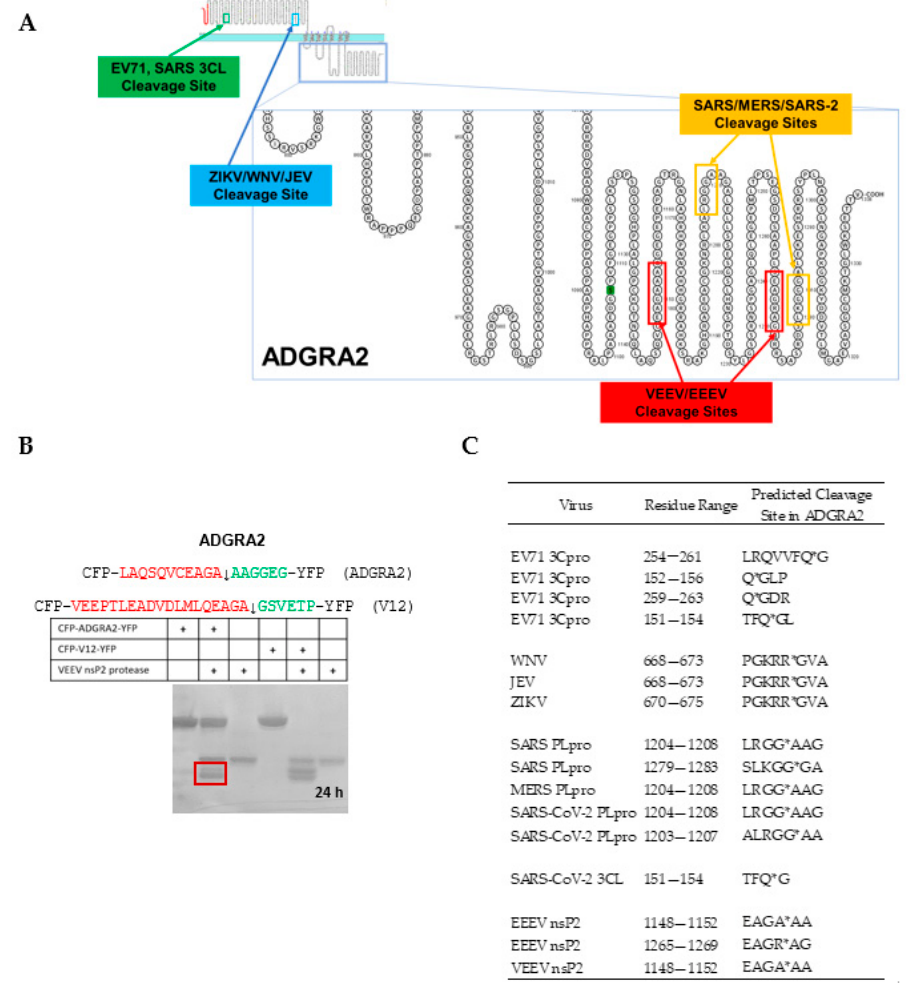
Figure 7. ADGRA2 (GPR124) is a common predicted hit among neuroinvasive viruses. ( A ) ADGRA2 (GPR124) is a G ‐ protein coupled receptor; the regions predicted to be in the cytoplasm by Protter [41] contain many of the predicted cleavage sites. ( B ) A substrate (10 μ M) containing one of the two predicted cleavage sites in ADGRA2 for the VEEV nsP2 cysteine protease (5 μ M) was cleavable. Cleavage products are boxed in red. The (+) signs indicate which enzymes, inhibitors, or substrates were present in the reaction for the lane in the gel. The V12 substrate (10 μ M) contains the natural nsP1/2 cleavage site; this substrate is cut to completion in the 24 h room temperature (23 ± 3 °C) incubation by the VEEV nsP2 cysteine protease (5 μ M). Whereas, the cyan ‐ yellow fluorescent protein (CFP ‐ YFP) containing the predicted ADGRA2 cleavage site was more slowly cut during the same incubation period. ( C ) Locations of the predicted viral protease cleavage sites in the ADGRA2 human sequence. Some sites are extracellular, while others are intracellular. Asterisks indicate the scissile bond.